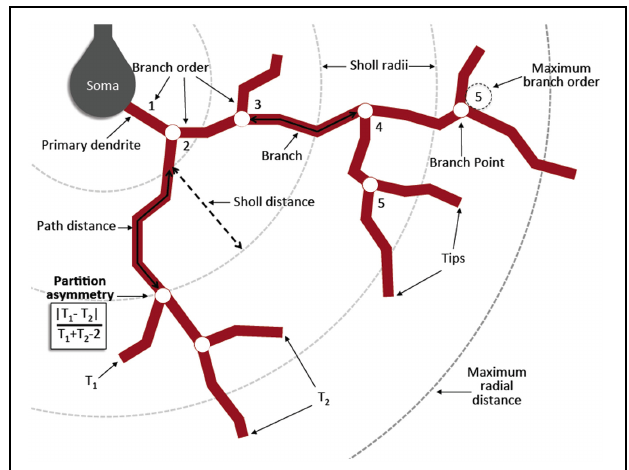
FIGURE 3 | Diagram of morphometric measurements. A primary dendrite is any dendrite originating from the cell body. A branch point occurs when the original dendrite bifurcates into two or more daughter trees. A centrifugal labeling scheme was used for assigning branch order , where the lowest order is given to the primary dendrites and increases when a branch point is reached. Maximum branch order is the maximum value reached by any primary tree on a given cell. A branch is a length of dendrite between the soma and a branch point, between two branch points, or between a branch point and a tip. A tip is the termination of any branch. Sholl radii are concentric spheres originating from the centroid of the soma and increasing at 10 µ m intervals. Maximum radial distance is the maximum Sholl radius reached by any single dendrite per cell. Partition asymmetry is calculated at each branch point as | T 1 –T 2 | /(T 1 + T 2 -2) where T 1 and T 2 are the number of tips of the two daughter trees, with values of one and zero indicating asymmetrical and symmetrical partitioning respectively. Contraction is calculated for each branch as a ratio between the Euclidean distance and the distance along the branch path. A value of one indicates perfectly straight dendrites, while lower values indicate increasing levels of tortuosity or winding of the dendrites. Derived in part from (Costa et al.,